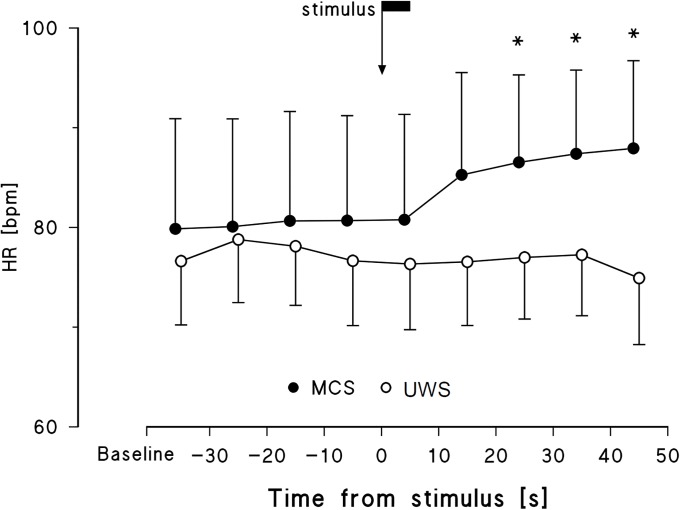
HR profile around the noxious stimulus in MCS and UWS patients.Data are mean and sem. The arrow pointing at t = 0 indicates the instant of stimulus application; the flag on the arrow indicates the duration of the stimulus (5 s); the * mark differences vs. baseline significant at p<0.05.